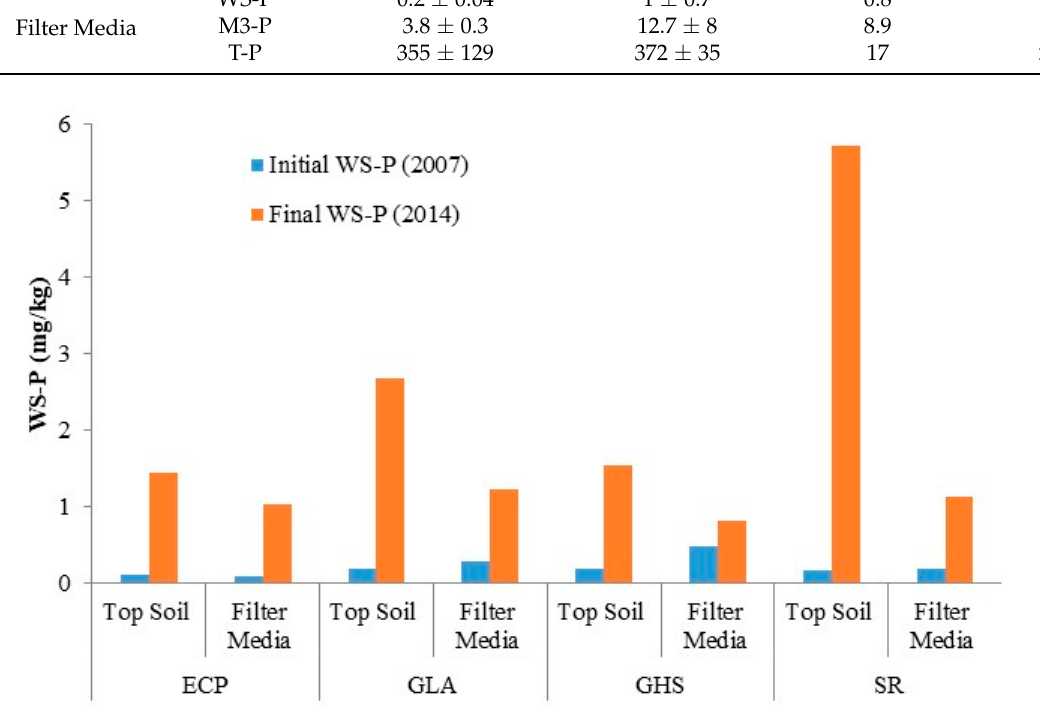
Figure 10. WS-P mass concentrations in top soil and filter media in 2007 and 2014.